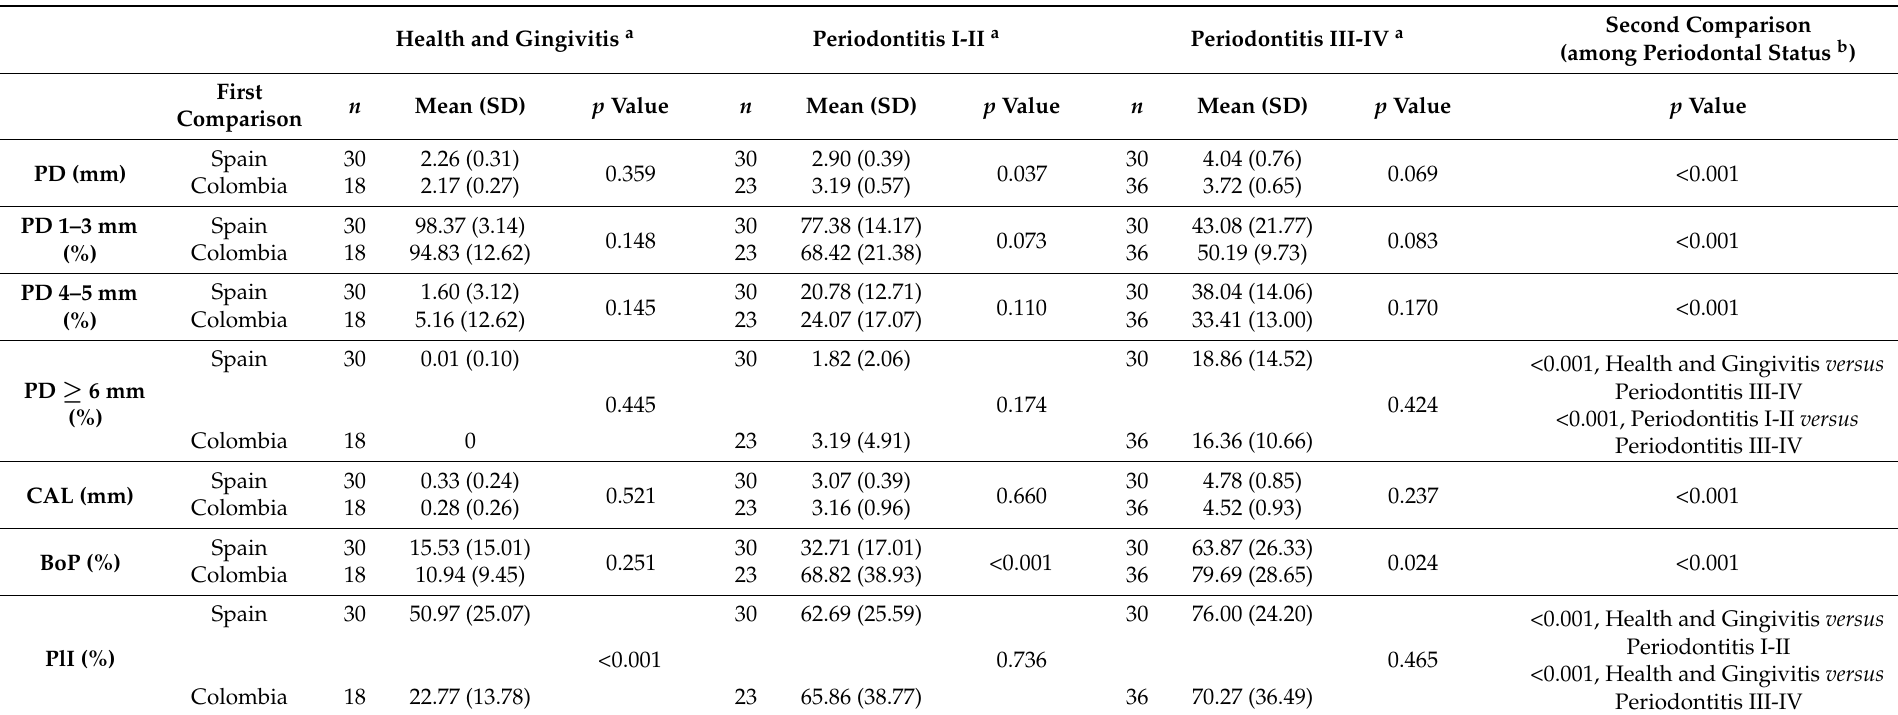
Table 3. Comparison of clinical parameters between countries (first comparison) and among periodontal status groups (second comparison). Health and Gingivitis a Periodontitis I-II a Periodontitis III-IV a